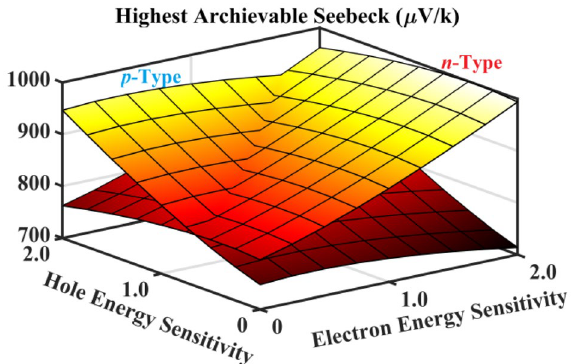
Figure 3. The highest achievable Seebeck coefficient at 300 K is obtained and exhibited for an ideal carbon nanotube network materials system with E g = 0.535 eV, as a function of energy sensitivities to electron/hole transport. It can be seen that the achievable Seebeck coefficient can be as high as in the order of ~ mV/K, instead of ~ μV/K in the measured data. This means that the band gap of the network for transport could be metallic, instead of semiconducting as expected by some early researchers. It also demonstrates that the highest achievable Seebeck coefficient for the p -type and the n -type regimes are monotonically increasing and